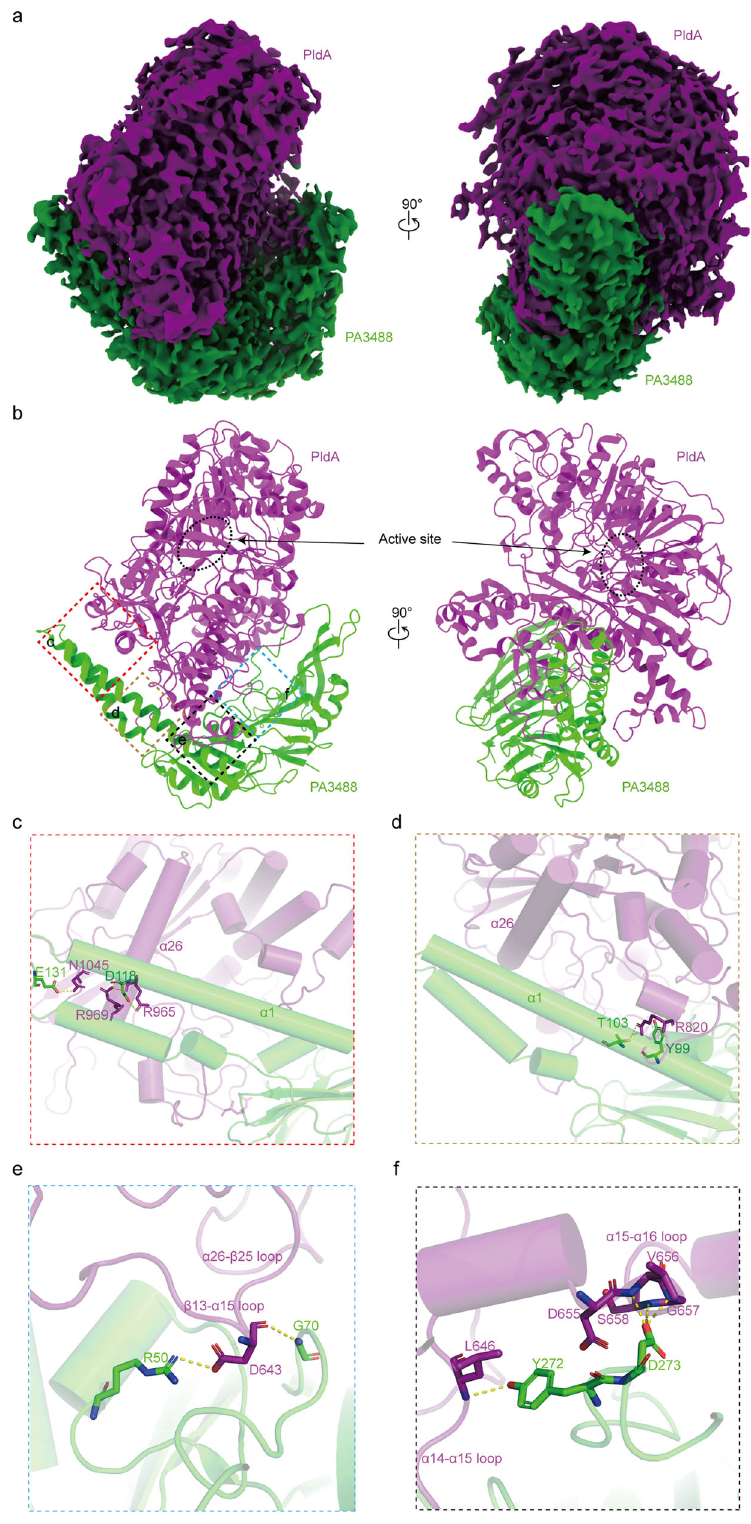
Fig. 4 | Cryo-EM structure of PldA – PA3488 complex. a , b Two orthogonal views of the cryo-EM density map ( a ) and model ( b ) of the PldA – PA3488 complex are shown: PldAand PA3488 are colored inpurpleand green, respectively. The dotted circle regions indicate the active site. c – f Details of the interaction between PldA and PA3488. The interaction residues are presented as sticks. Close-up view of